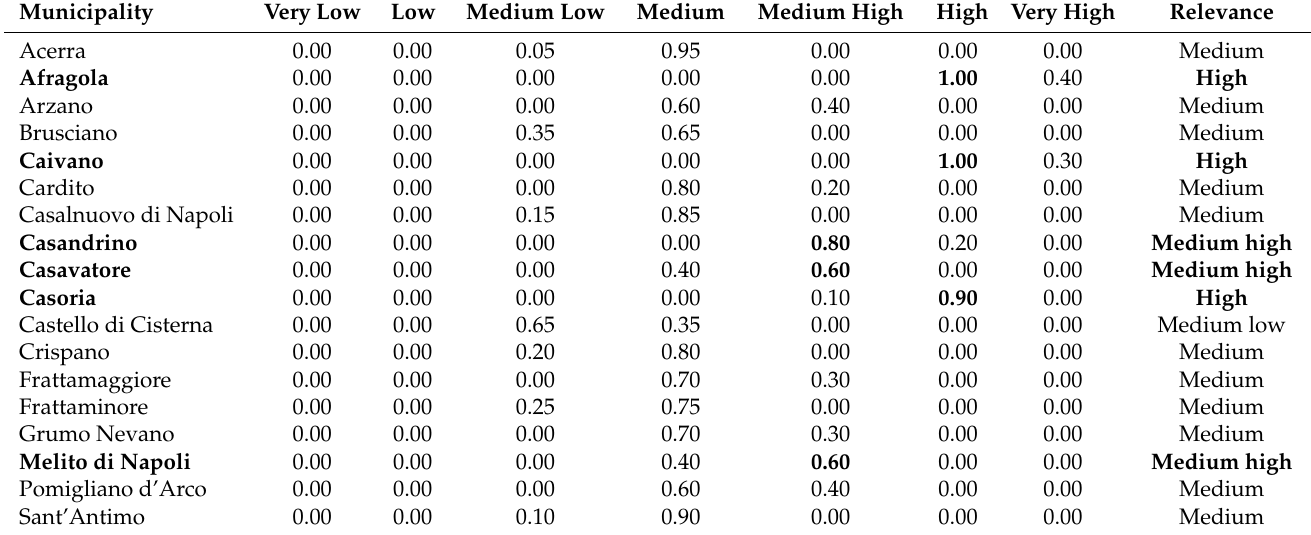
Table 3. Relevance of unpleasant emotional categories in the year